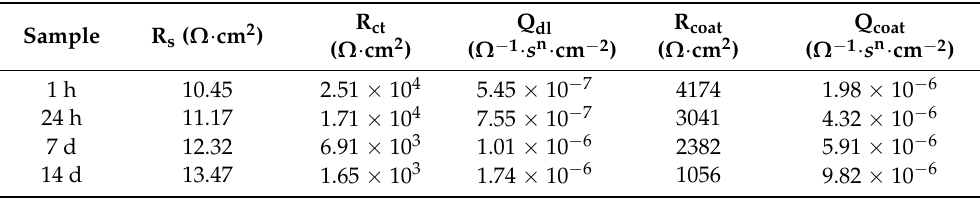
Table 1. Fitting results of EIS data for bare steel and coated steel immersed in a 3.5 wt% NaCl solution for 1 h, 24 h, 7 d and 14